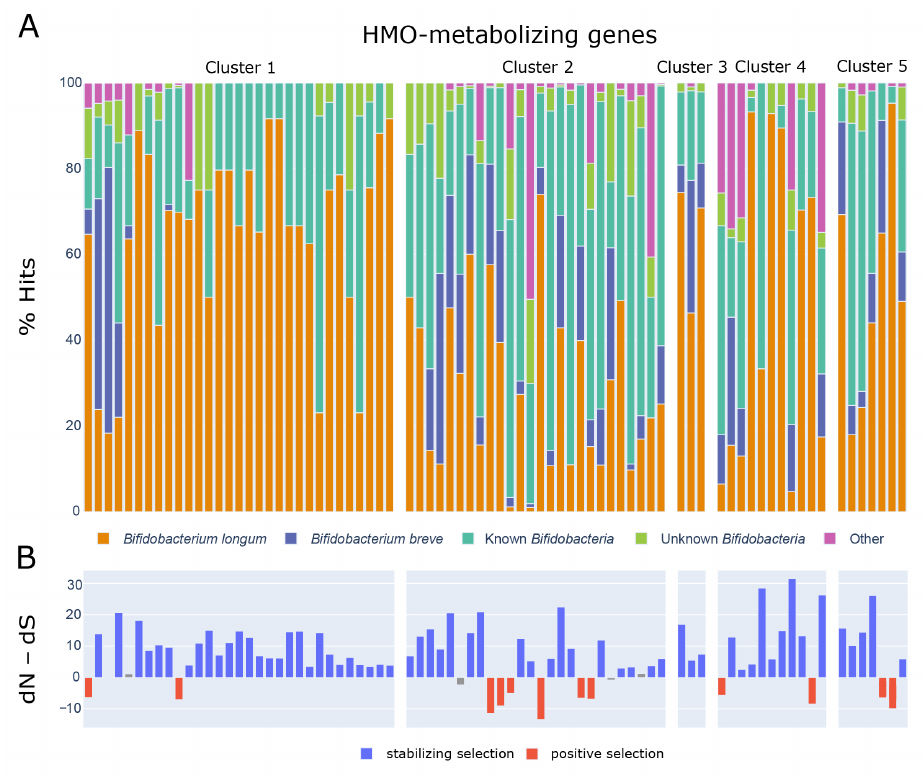
Figure 3. ( A ) Stacked bar plot showing taxonomic assignment of BLASTP hits (NCBI non-redundant database) for each HMO metabolizing gene. Known Bifidobacterium include any specified species in the Bifidobacterium genus other than B. longum or B. breve . Unknown Bifidobacterium include any unspecified Bifidobacterium taxa ( Bifidobacterium , Bifidobacterium spp.). ( B ) Statistics from dN–dS analysis showing the probability and certainty that a given gene within the HMO-metabolizing gene clusters are under stabilizing or positive selection. Colored bars indicate statistical significance ( p < 0.05). Analyses were conducted using the Nei-Gojobori method in MEGA X. All ambiguous positions were removed for each sequence pair (pairwise deletion